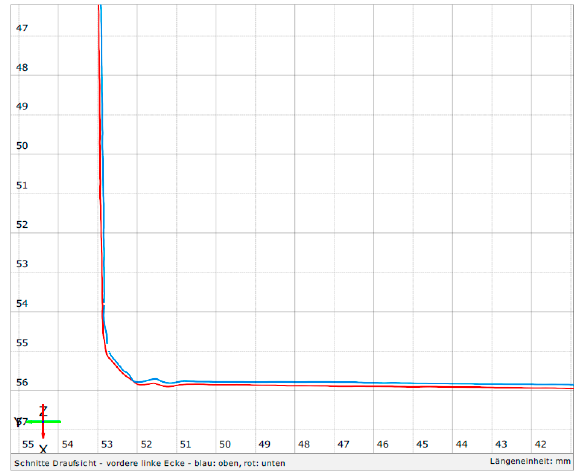
Figure 9. GOM measurement of superimposed planes from top view; manufacturing direction: al-